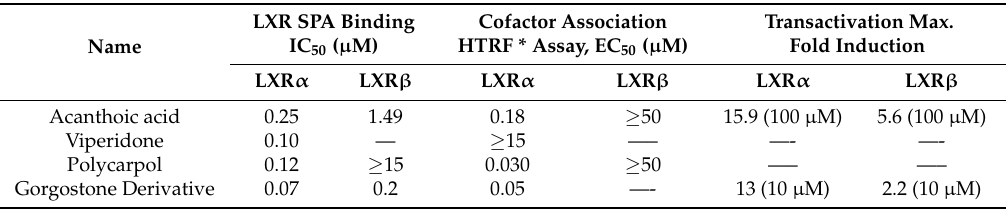
Table 2. LXR activities of diterpenoids, steroids and